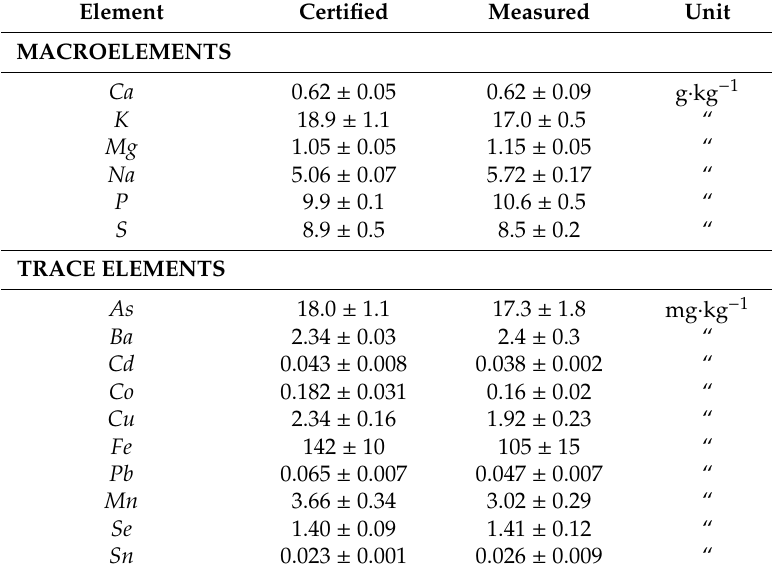
Table 1. Accuracy control of the analytical procedures for the assessment of macroelements and trace elements *.